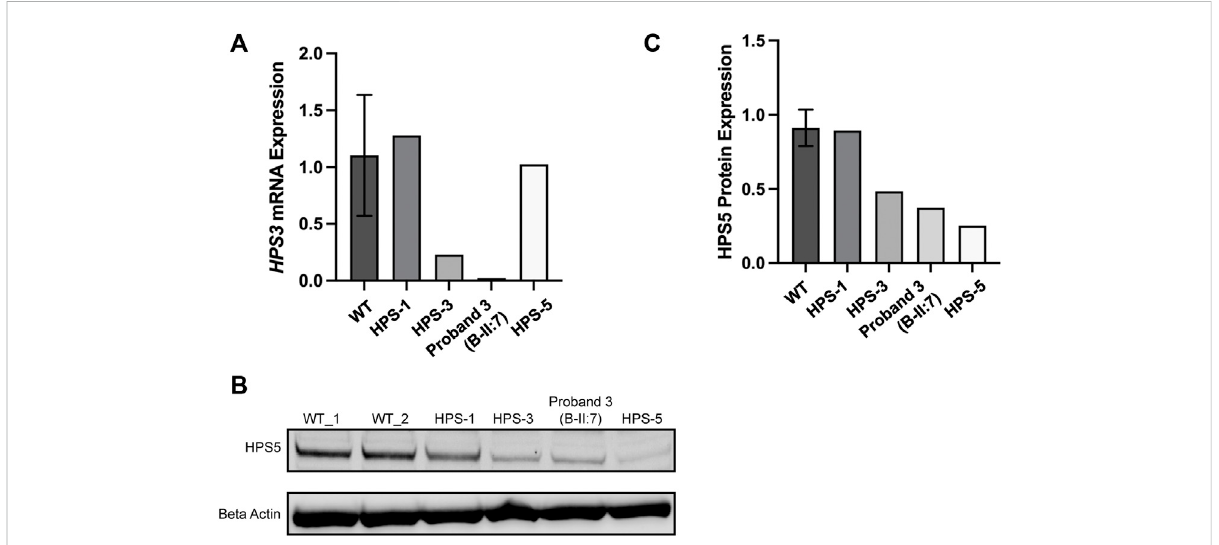
Molecular analysis of the compound heterozygous probands. (A) HPS3 mRNA expression in fi broblasts from four different WT controls, Hermansky – Pudlak syndrome (HPS)-1 (patient with biallelic mutations in HPS1 ), HPS-3 (patient with biallelic mutations in HPS3 ), and HPS-5 (patient withbiallelicmutationsin HPS5 ).Proband3isB-II:5andwithHPS-3disorder. HPS3 mRNAexpressionisreducedinpatientswithbiallelicmutationsin HPS3 as compared with control. (B) Western blotting from the mentioned above samples probing for HPS-5 aiming to evaluate